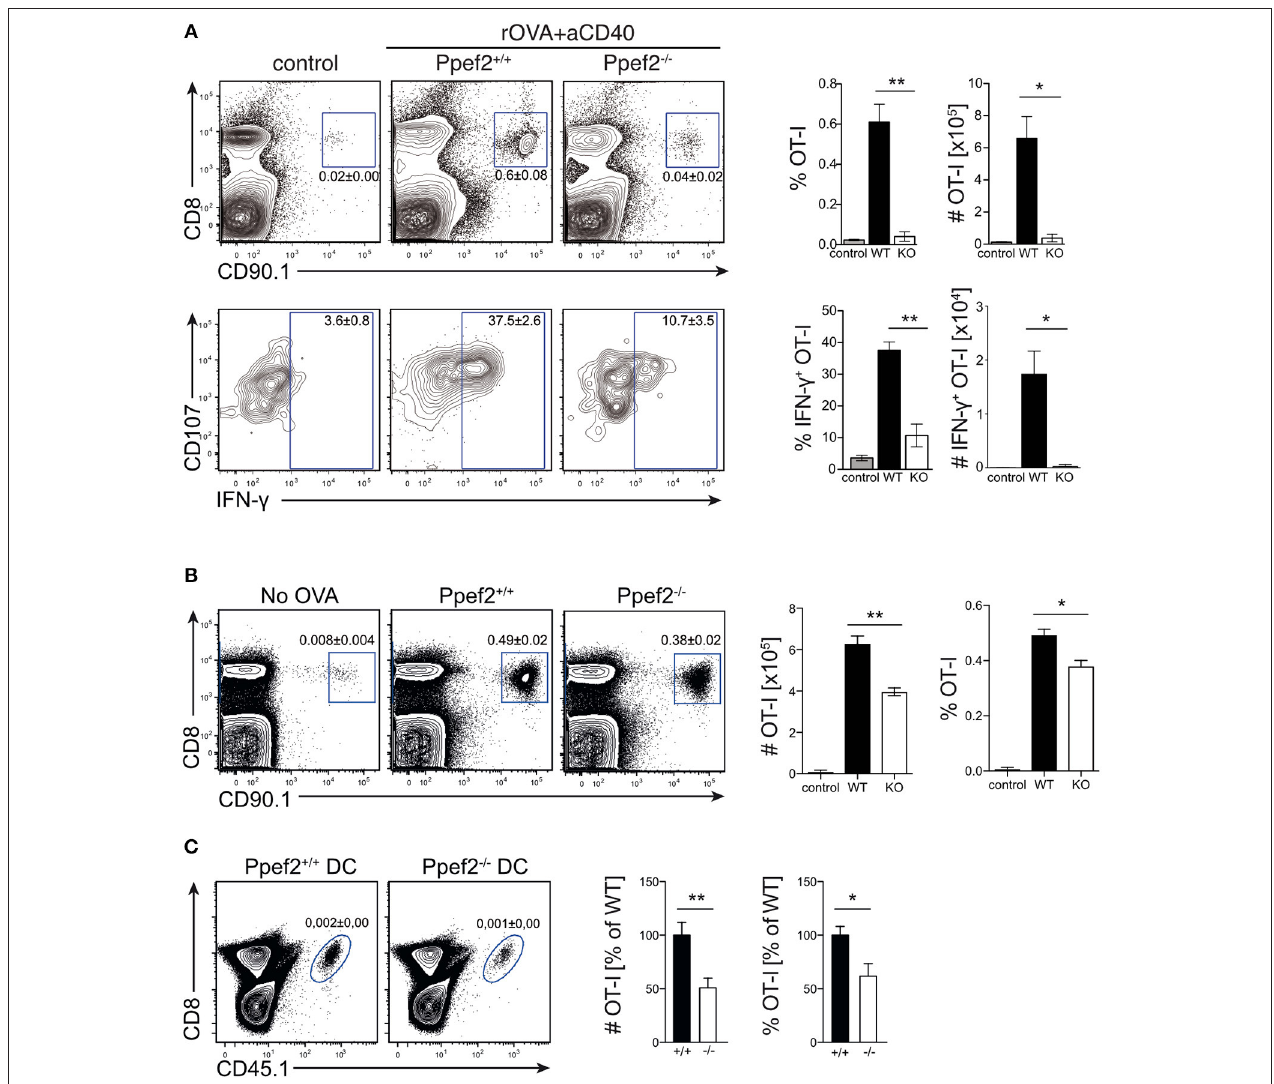
FIGURE 7 | Ppef2 − / − DCs display decreased CD8 + T cell priming capacities. (A) 5 × 10 5 congenitally marked CD90.1 + OT-I T cells were adoptively transferred either in Ppef2 + / + or Ppef2 − / − mice, which received 30 µ g OVA protein and 100 µ g CD40-specific mAb intravenously 1 day later or received OT-I T cells only (control). On day 7 post immunization spleens were analyzed for frequencies and total cell numbers of CD90.1 + CD8 + OT-I cells as shown in the respective bar graphs (upper panel). Spleen cells were cultured in vitro with OVA257 peptide in the presence of CD107a-specific mAb and subsequently stained for CD8 and IFN- γ (lower panel) to determine IFN- γ -producing OT-I T cell frequencies and total cell numbers (bar graphs). Shown are results from one experiment out of two with similar results and n = 4 mice per group. (B) 5 × 10 5 congenitally marked (CD90.1) OT-I T cells were adoptively transferred either in Ppef2 + / + or Ppef2 − / − mice, which received 100 µ g OVA protein intravenously 1 day later. Mice were sacrificed 3 days after OVA administration and spleens were analyzed by flow cytometry for OT-I T cell proliferation. Shown are representative FACS-plots of OT-I T cells of one out of two independently performed experiments with similar outcome. Data from two independent experiments were pooled ( n = 6) to determine the total cell number and frequencies of CD90.1 + CD8 + OT-I T cells. (C) 1.5 × 10 5 Ppef2 + / + or Ppef2 − / − DCs were pulsed with OVA257 peptide and transferred i.v. into H-2K bm1 recipient mice. 24h later H-2K bm1 OT-I T cells were transferred and mice were analyzed 3 days later for presence of CD45.1 + CD8 + OT-I T cells by flow cytometry. Shown are representative FACS-plots of the gated CD45.1 + CD8 + OT-I T cells. Two independently performed experiments were pooled ( n = 6) to determine the relative frequency and total cell number of CD45.1 + CD8 + OT-I T cells from the gates shown in (C) . Statistical analysis was performed using Student’s t -test, with * p < 0.05; ** p <